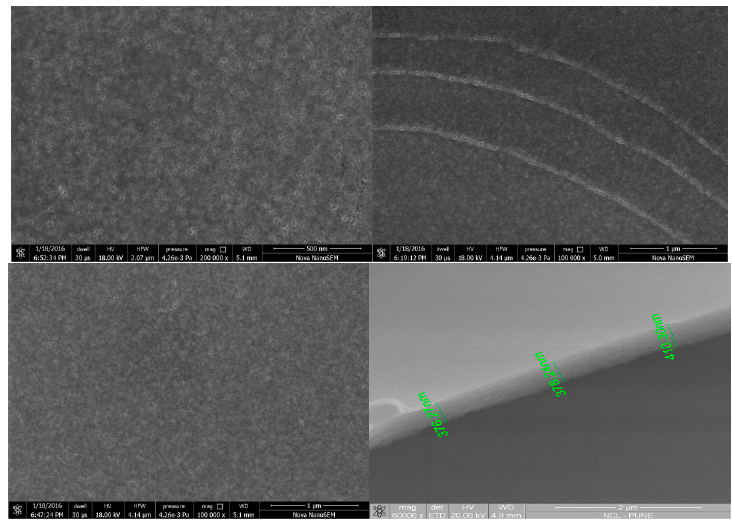
Figure 3. Scanning electron microscopy images of the thin film GSM-23F on various magnifications and the cross-sectional analysis of such a thin film.